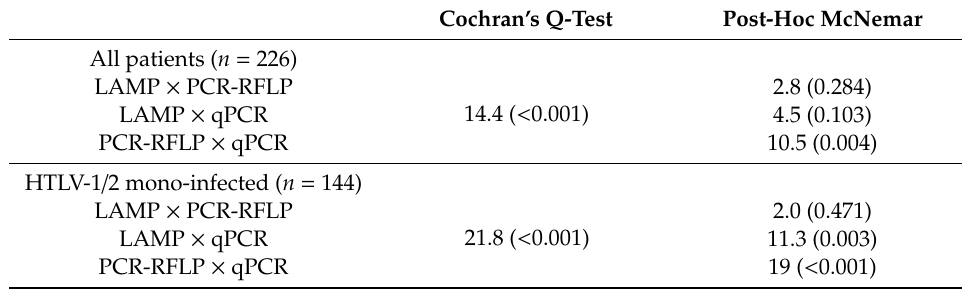
Table 3. Agreement between molecular assays in the diagnosis of HTLV-1 / 2